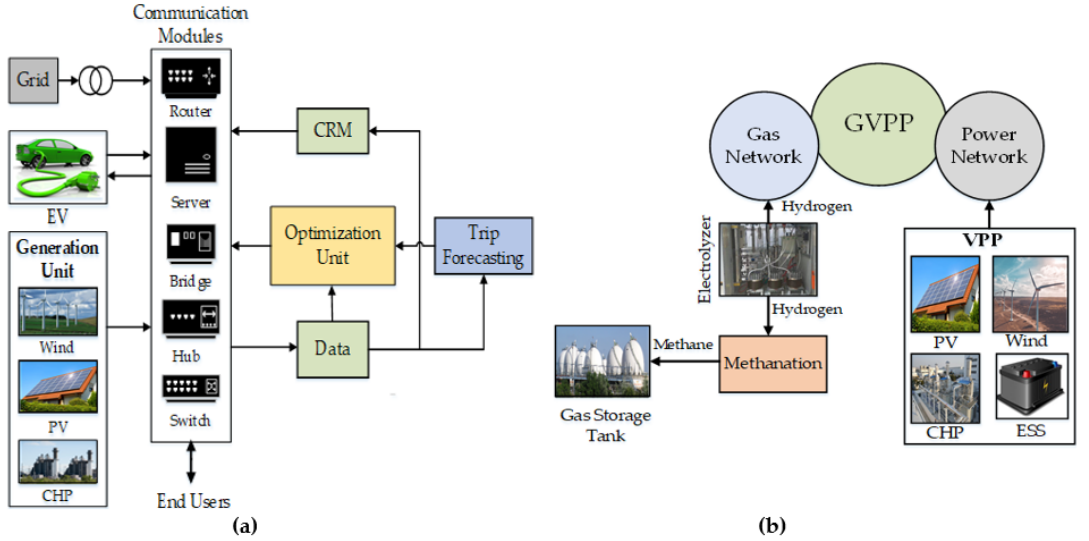
Figure 9. A schematic representation of the virtual power plant for ( a ) trip prediction algorithm; ( b ) multi-objective robust scheduling model (Redrawn with permission from [80], 2019, Elsevier). (Note: PV-photovoltaics; CHP-combined heat and power; CRM-customer relationship management; GVPP-gas based virtual power plant; VPP-virtual power plant; ESS-energy storage system).